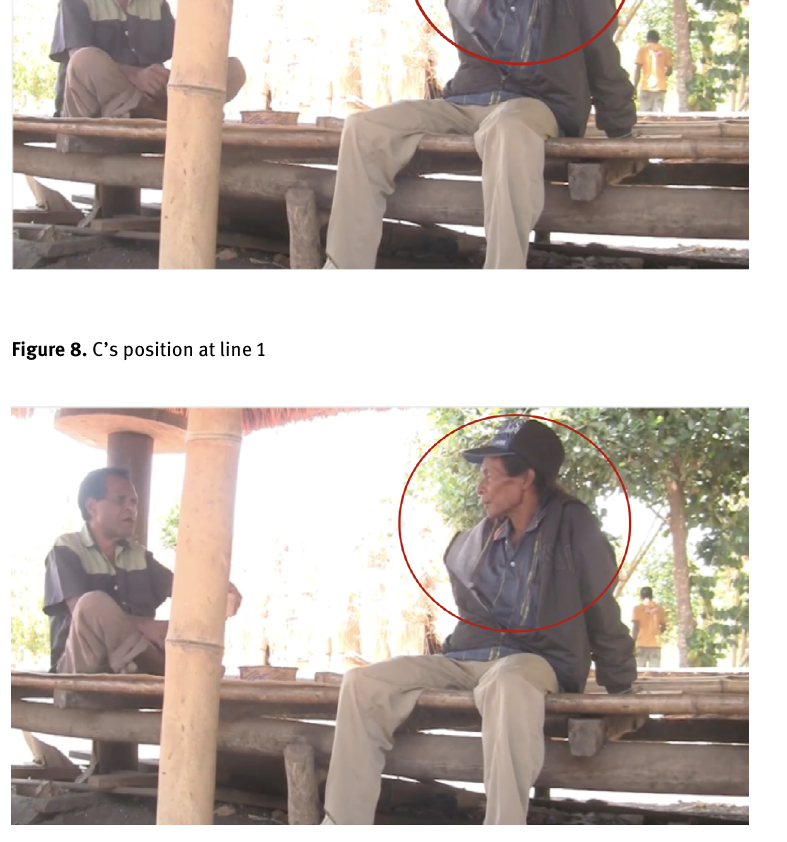
Figure 9. C closes his